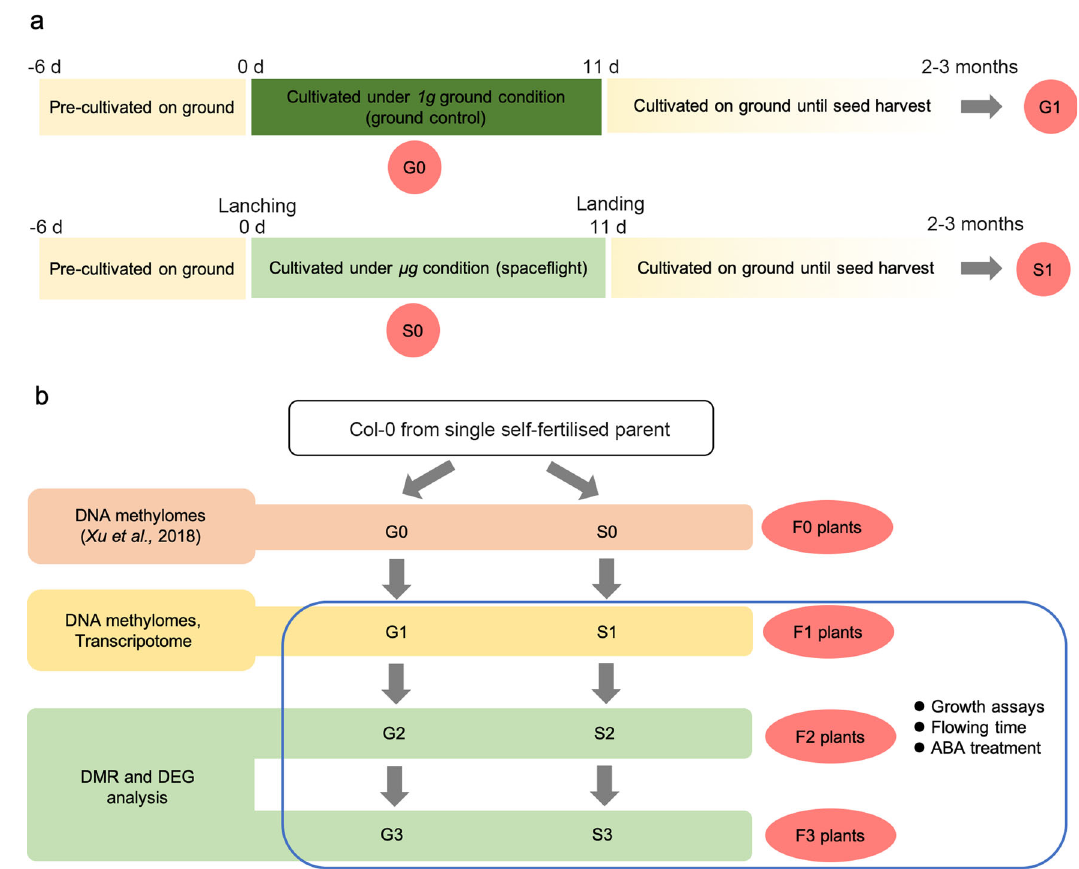
Fig. 1 Schematic of experimental procedures on board the SJ-10 recoverable satellite and follow-up experiments. a Schematic diagram of Arabidopsis seedlings on board the SJ-10 satellite in space fl ight and on the ground, and the follow-up experimental design arrangements. Arabidopsis seedlings were transferred from petri dishes 3 d before launching. Seedlings in culture chambers installed in growth chamber unit 1 were grown under microgravity conditions and fi xed in space using RNAlater ® as described in the previous report 13 . The seedlings in the culture chamber installed in growth chamber unit two in the satellite grew for 11 days under microgravity; after this time of space fl ight, they were still alive, were returned to Earth, and cultivated until seed harvest. b Multiple independent lineages began with individual inbred Arabidopsis plants, propagated by single-seed descent, with self-fertilization, for three generations, with half of the lineages exposed to the microgravity of space and the remainder maintained on Earth. Intergenerational stress memory tests were performed on the offspring plants. Whole-genome bisul fi te sequencing (WGBS) and transcriptome analyses were performed on the F 1 generation. Various growth phenotypes were assessed in successive F 1 , F 2 , and F 3